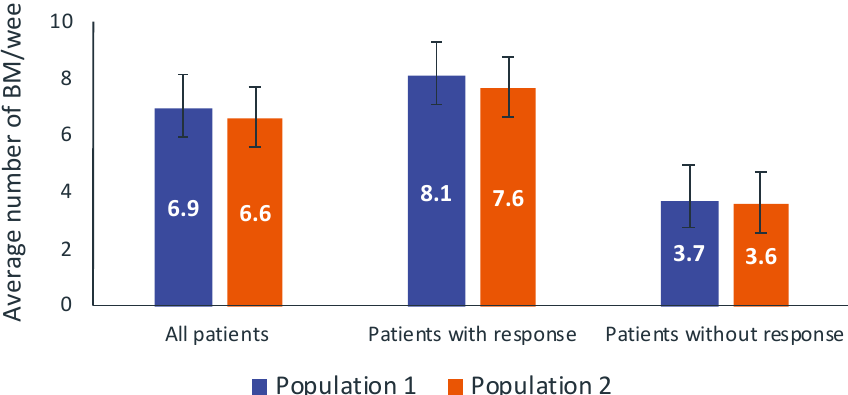
Figure 2. Average number of bowel movements per week over study efficacy Populations 1 and 2. BM, bowel movement. Vertical bars represent 95% confidence intervals. Population 1: Subjects who had completed both 4 weeks of treatment and 28 days of the diary. Population 2: Subjects who had completed at least 21 days of the diary.